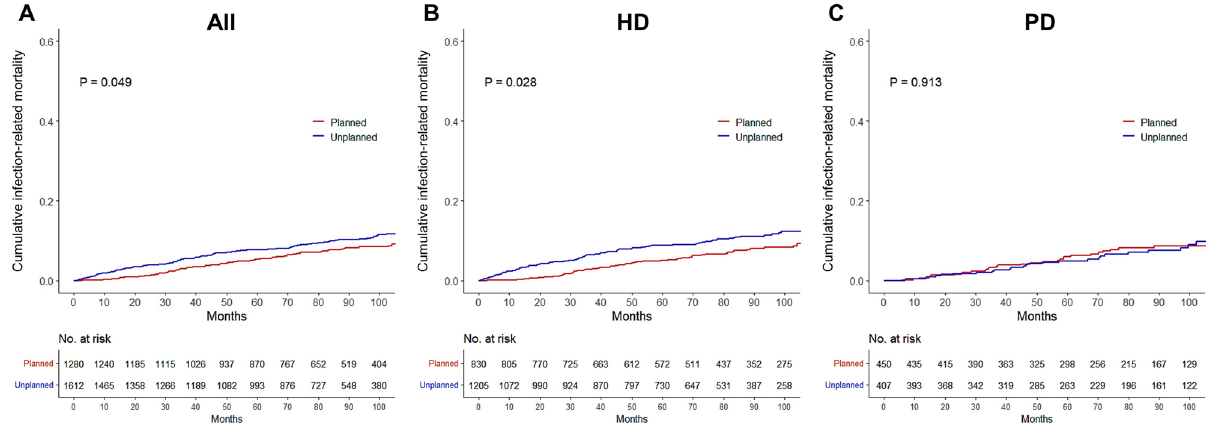
Figure 2. Kaplan–Meier curves for the cumulative risk of infection-related death according to planned dialysis ( A ) All patients ( B ) Patients undergoing hemodialysis ( C ) Patients undergoing peritoneal dialysis. HD hemodialysis, PD peritoneal